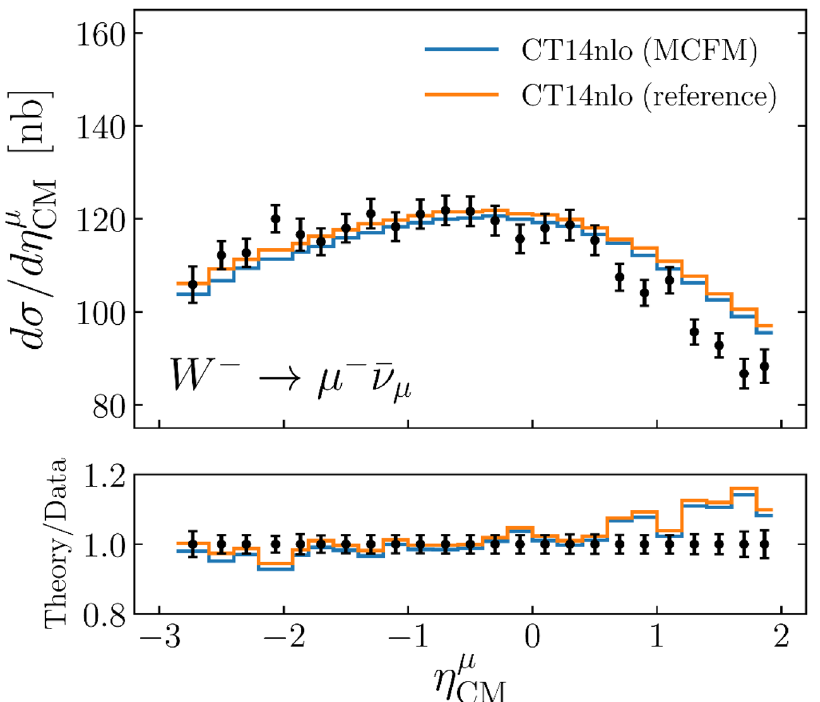
p s = 8 : 16 TeV in the